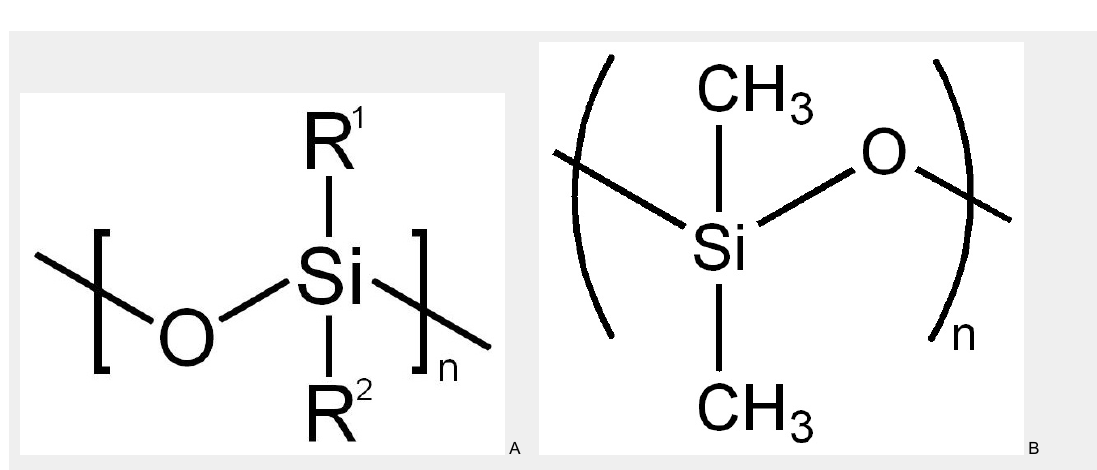
A B Figure 2 The siloxane “backbone” of silicone polymer molecules, shown (A) generically and (B) specifically with methyl (CH3) groups attached to produce the most common siloxane, polydimethylsiloxane (PDMS). This is the siloxane used to form both the silicone rubber and the silicone gel used in breast implants. Other organic groups can be attached instead of methyl to produce other siloxanes with other properties. Source: Wikimedia